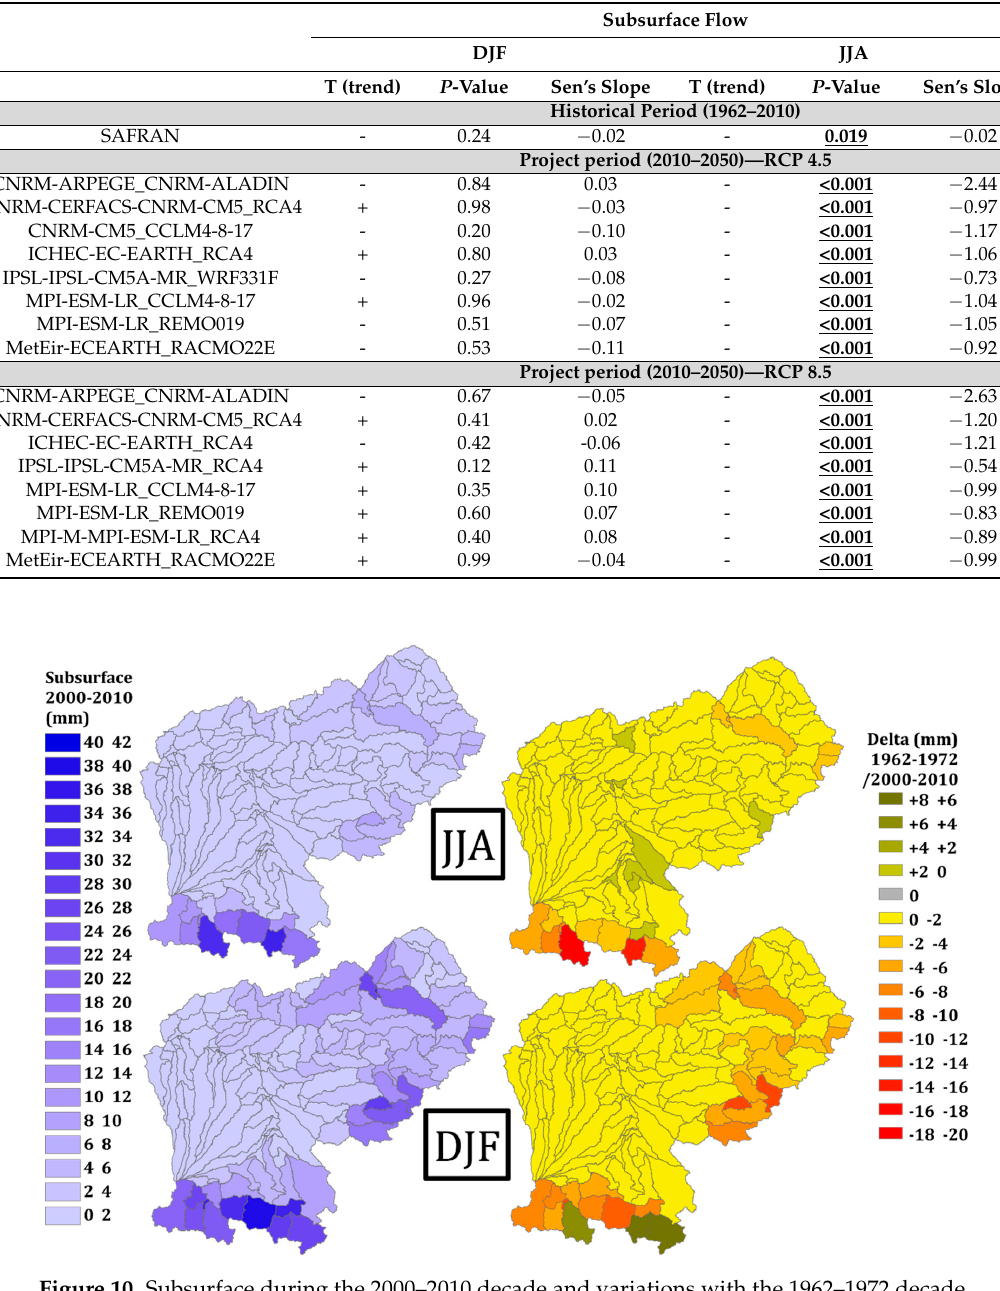
Figure 10. Subsurface during the 2000–2010 decade and variations with the 1962–1972 decade. The two last components of the water cycle examined in this study are green water